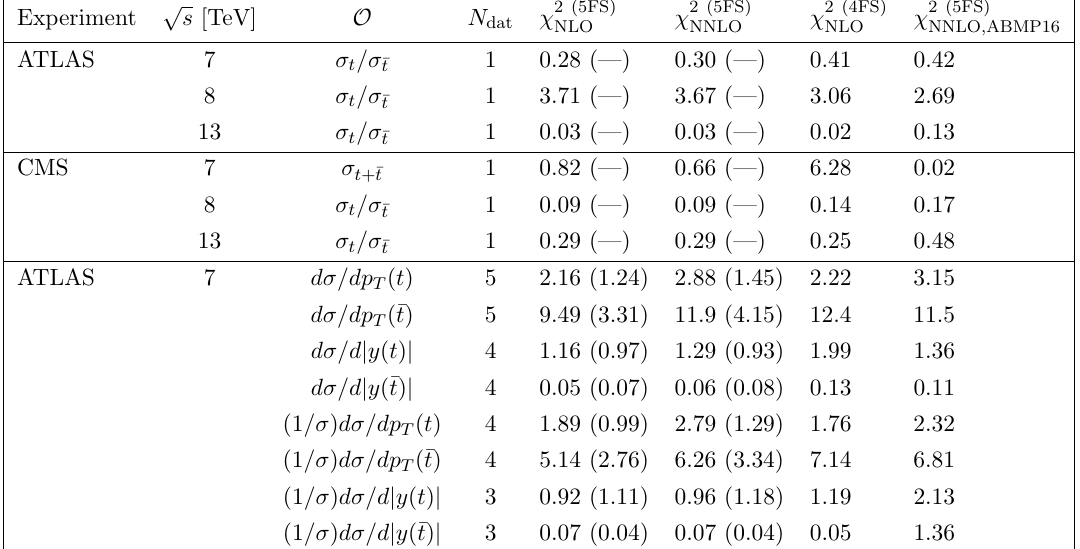
Table 4 . The values of the (cid:31) 2 , eq. (3.2), computed for all of the datasets described in section 2 and collected in tables 1{2. For ease of reference, we indicate the centre-of-mass energy of each p measurement, s , the corresponding observable, O , and the number of data points, N dat . The- oretical predictions are computed at either NLO or NNLO accuracy in the 5FS or at NLO accu- racy in the 4FS, always in pure QCD; the input PDFs are taken from the NNPDF31 nlo as 0118 , NNPDF31 nnlo as 0118 and NNPDF31 nlo as 0118 nf 4 sets, respectively. Values in parentheses do not include bin-by-bin experimental